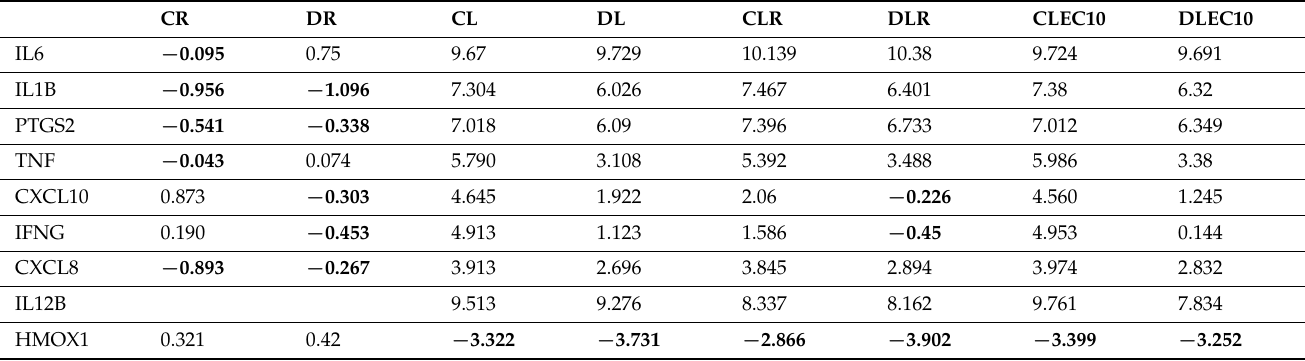
Table 2. A summary of gene expression (Log2-fold values) of selected cytokines and other key mediators of signaling pathways. RNA was extracted from PBMCs from PwD2 (D), and non-diabetic controls (C) after treatment with RES (CR, DR), LPS (CL and DL), RES + LPS (CRL and DLR), LEC10 (CLEC10 and DLEC10), and values were analyzed using RNAseq (NGS) followed by IPA. Downregulated genes are